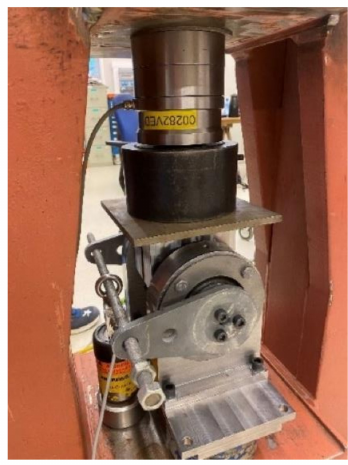
Figure 7. Test set-up for Test